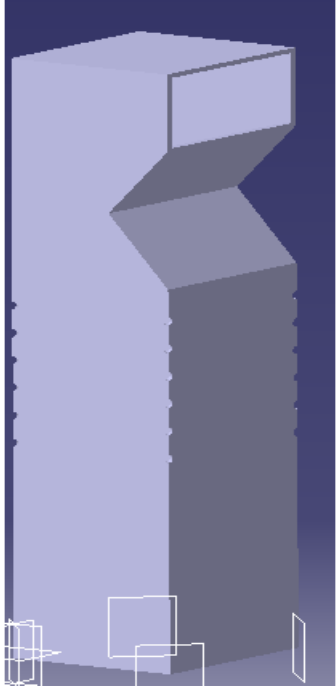
Figure 5. Supercritical Boiler front